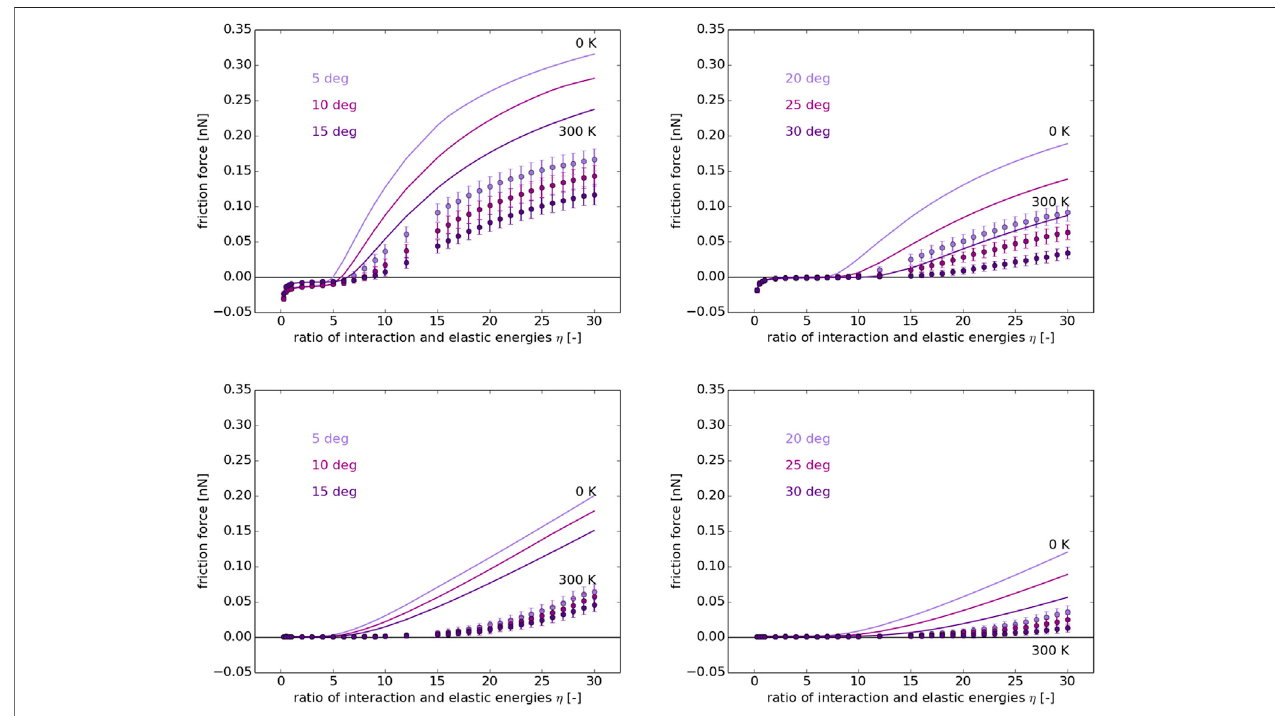
FIGURE 7 | η -dependence of structural superlubricity as predicted by the 1D PT-model at 0 K (solid line) and at RT of 300 K (full circles) along various incommensurateslidingpaths Φ (cid:2) 5,10,15,20,25and30deg(depictedinvioletasspeci fi edinthelegend),recall Figures1 , 2 ,wheneither U 0 (toprow) or k c (bottom row) is kept constant in Eq. 14 .